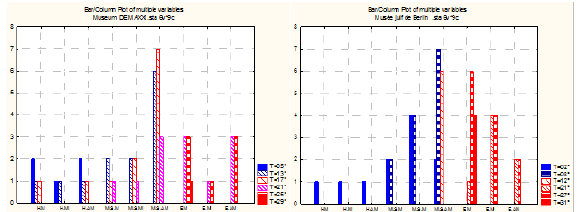
Figure 08 : Diagram of variation in number of temperature segments, daily and seasonal variations